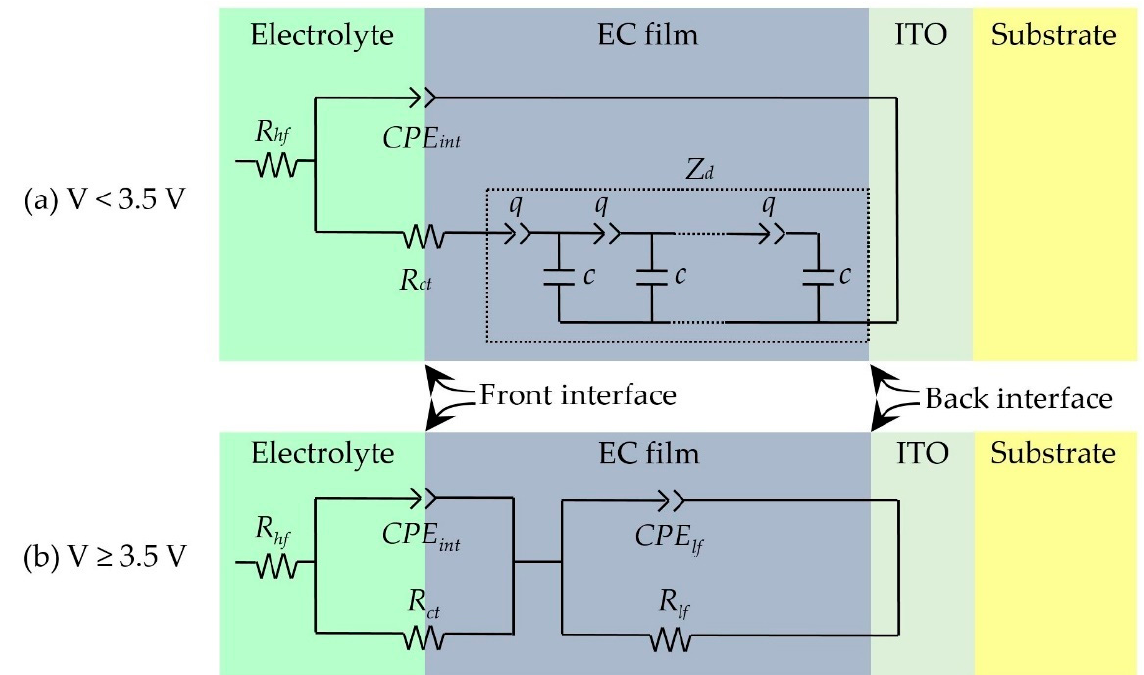
Figure 1. ( a ) Equivalent circuit used at potentials below 3.5 V vs. Li/Li + and constituent electrochemical system: an EC film immersed in an electrolyte. The rectangle within the bluish background delineates a transmission-line representation of the diffusion impedance Z d for “anomalous diffusion 1b” (cf. main text). ( b ) Corresponding equivalent circuit used for potentials above 3.5 V vs. Li/Li + .